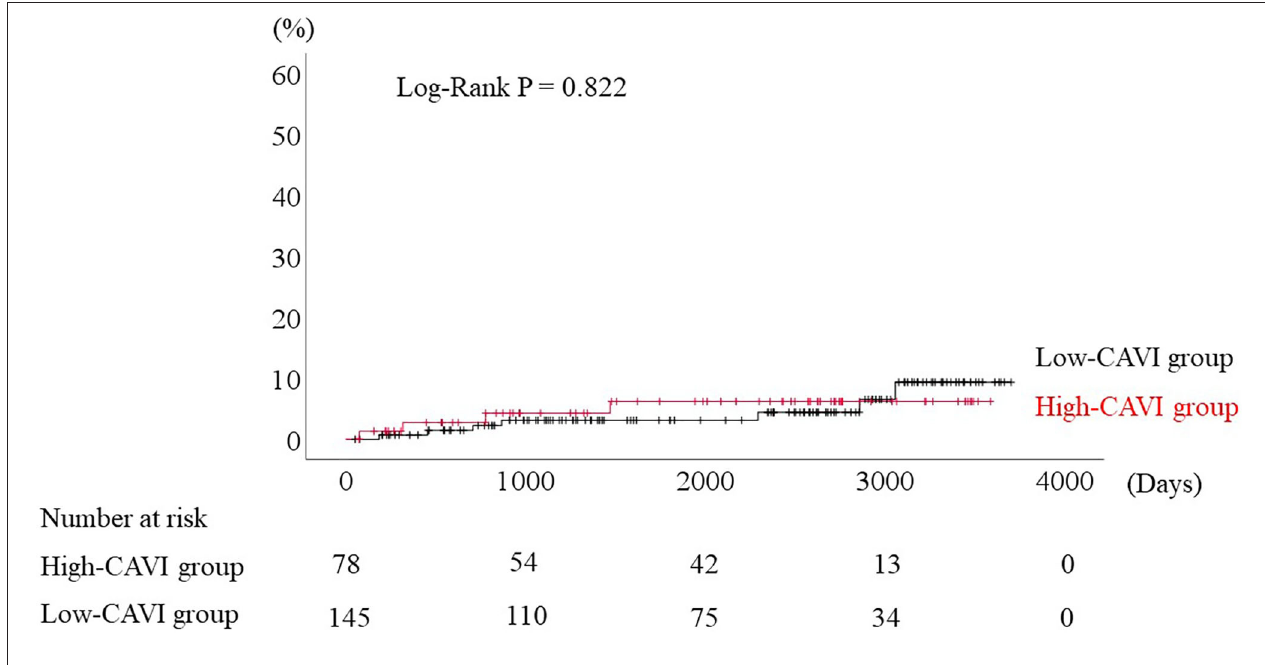
FIGURE 4 | Accumulated all-cause mortality stratified by CAVI.